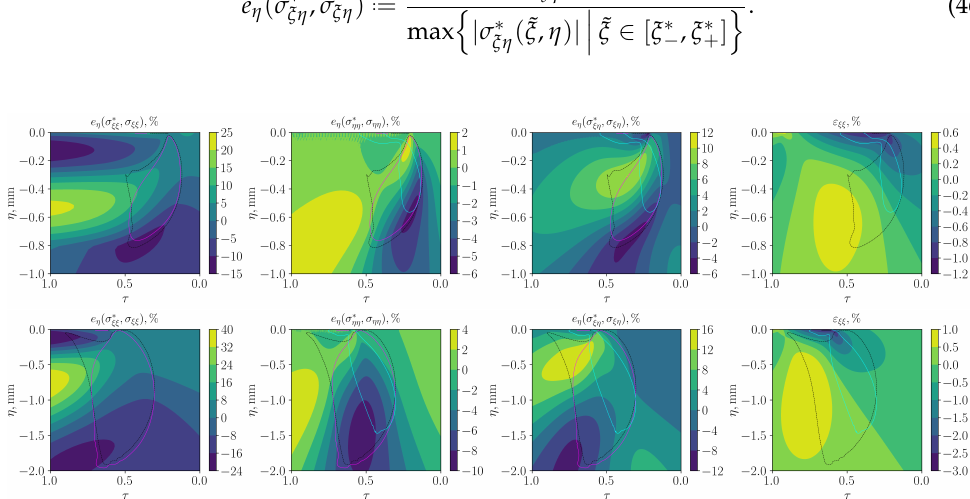
Figure 12. Deviations of the actual stress and strain components involved in the assumptions in Equations (11) and (12) as computed by a transient elastoplastic FE analysis of the half-space model (Figure 4) from their respective target values assumed in the approximate algorithms (top row of = 1.6kN, bottom row: h = 10GPa and p ∗ = 3.2kN). The dashed black plots: h = 2.5GPa and p ∗ 0 0 and the solid cyan and magenta lines are drawn as rough indicators of the areas where plastic flow occurred as per the FE analysis and the (implicitly integrated) MM and JS algorithms,